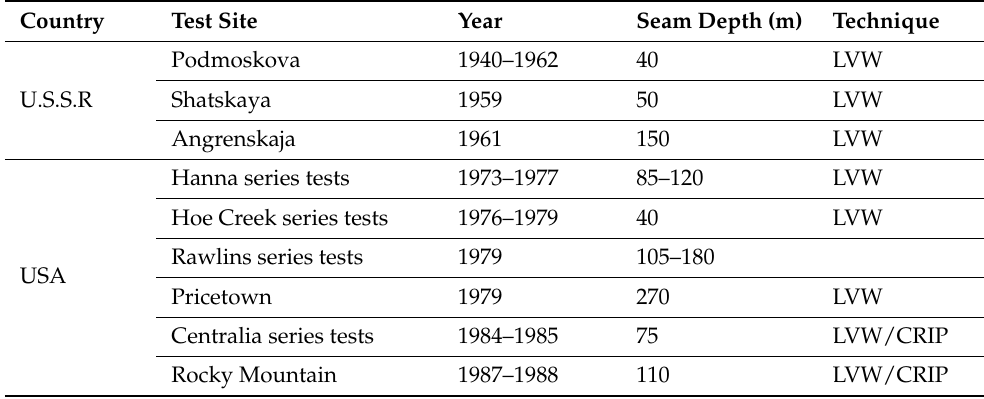
Table 2. Buried-depth statistics of UCG field tests (modified from